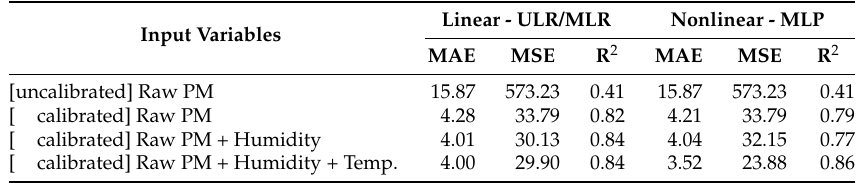
Table 5. Comparison of calibration performance by input variables (long-term: 80%—training dataset, 20%—test dataset, shuffled method, 5 min sampling interval condition)